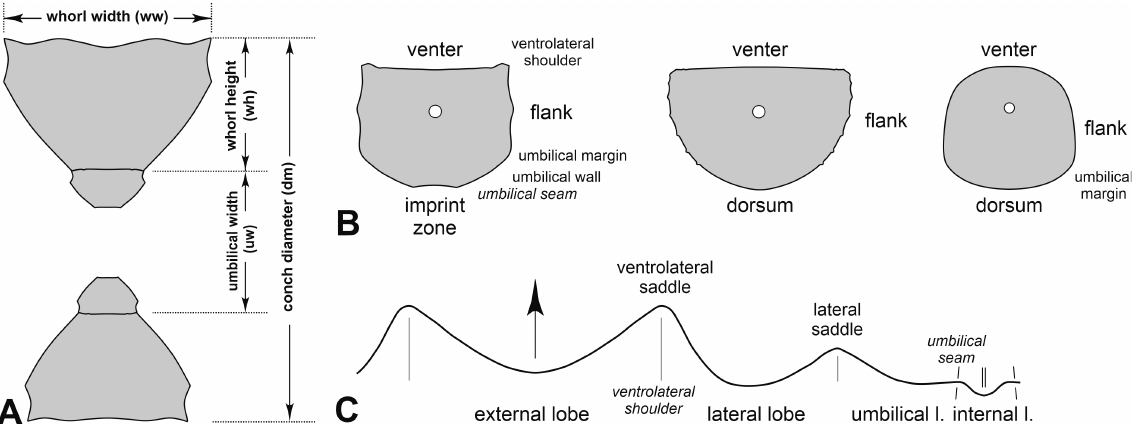
Fig. 3. The conch and suture line parameters used in the taxonomic descriptions. A . Conch parameters. B . Descriptive terms of whorl profiles. C . Suture line